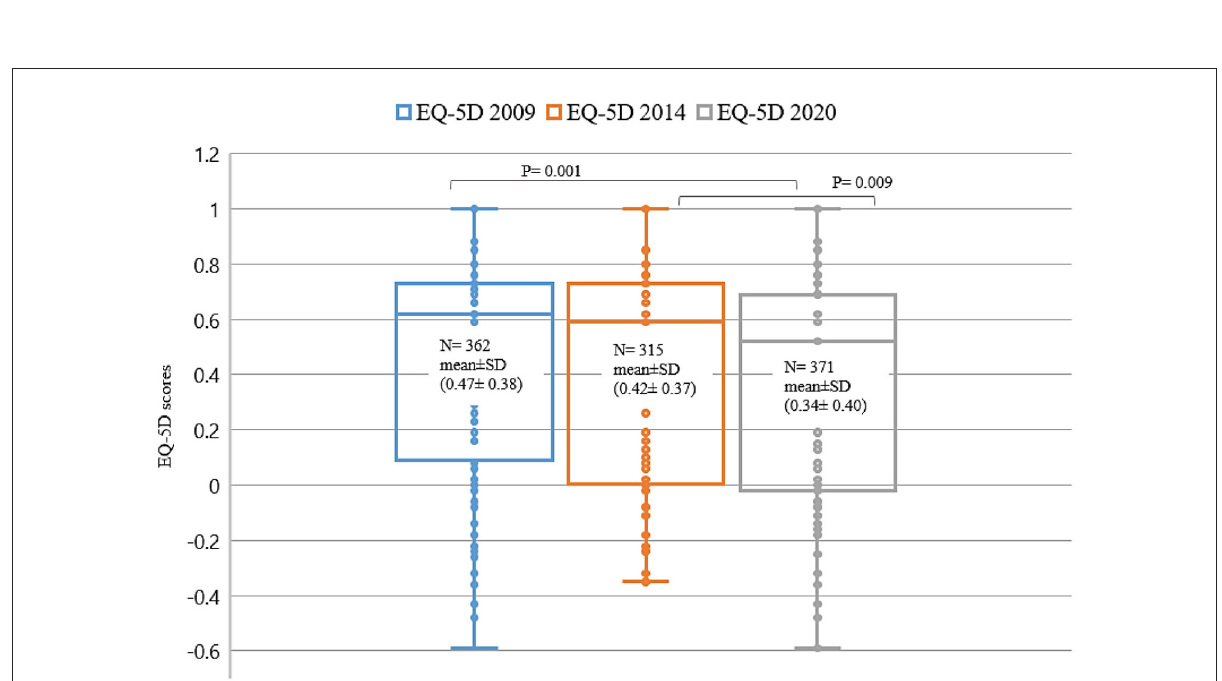
FIGURE3 The differences of EQ-5D index for 2009, 2014, and 2020 patients. The EQ-5D (means ± SD) indices for 2009, 2014, and 2020, were; 0.47 ± 0.38, 0.42 ± 0.37, and 0.34 ± 0.40, respectively; p <